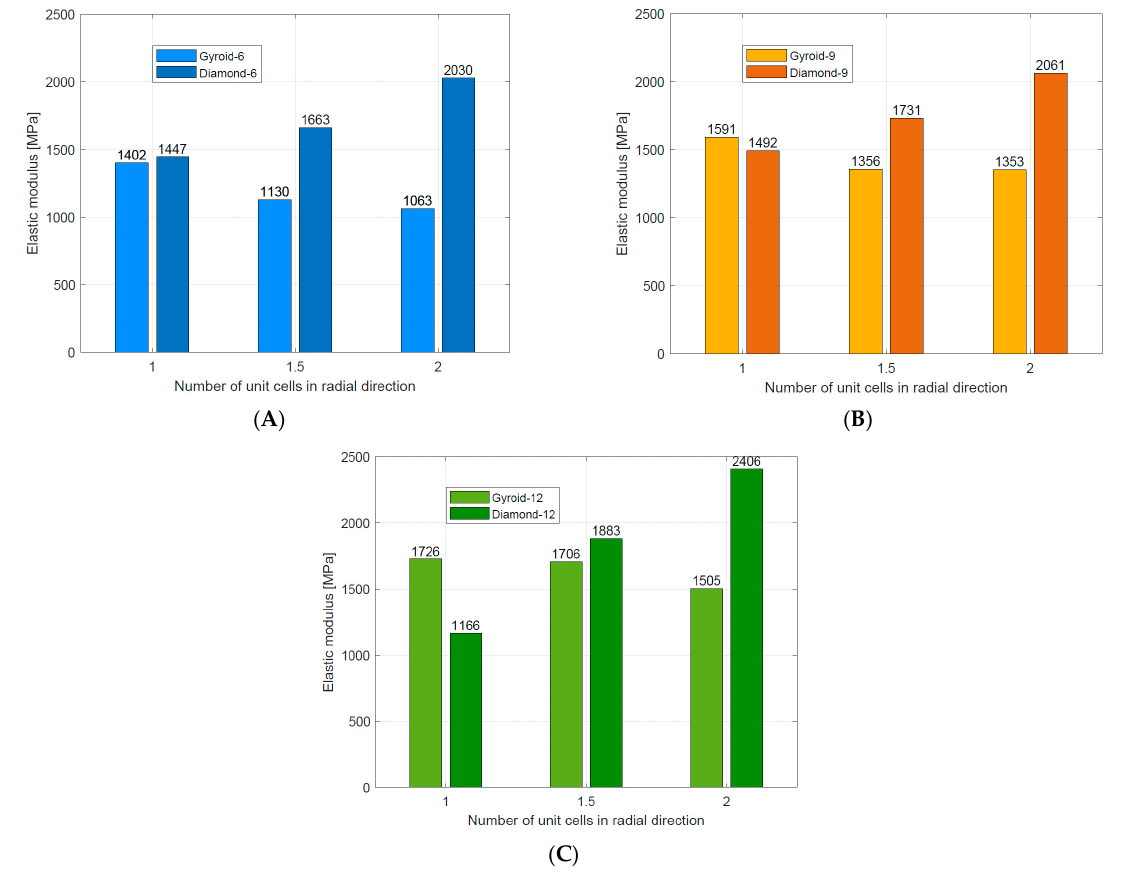
Figure 14. Comparison of elastic modulus for Gyroid [49] and Diamond TPMS cylindrical structures with ( A ) n circum = 6; ( B ) n circum = 9; ( C ) n circum = 12.